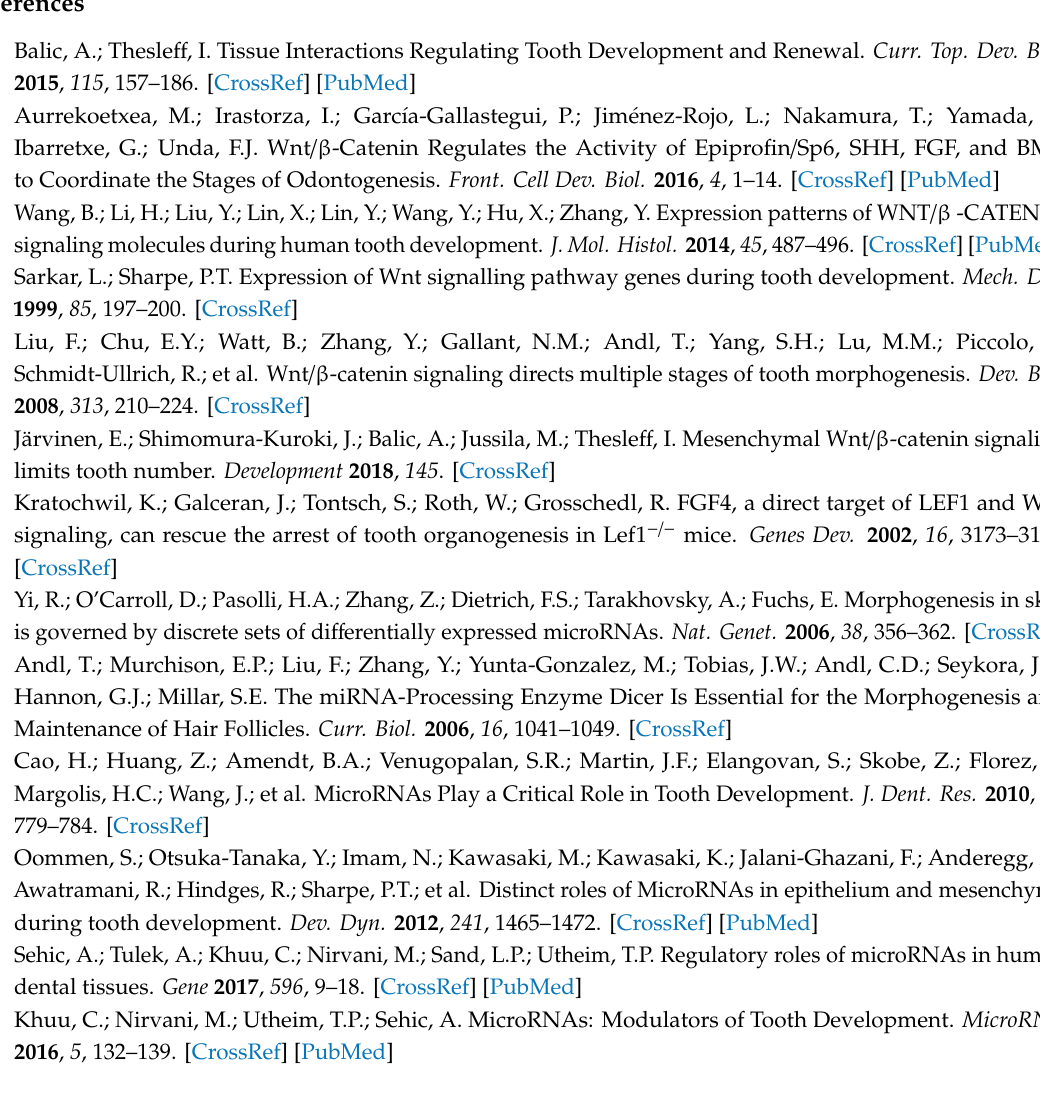
Figure S1. Evaluation of the e ffi ciency of inhibitor / mimic transfection during in vitro organ cultivation. Figure S2. Localization of E-Cadherin in E13 + 2 day teeth. Figure S3. The putative binding sites of mmu-miR-206-3P are broadly conserved among the Wnt3 and Fzd7 3’ UTRs of vertebrates. Figure S4. Whole-mount in situ hybridization. Figure S5. Lower magnification of H&E-stained histological sections of the renal-capsule–calcified